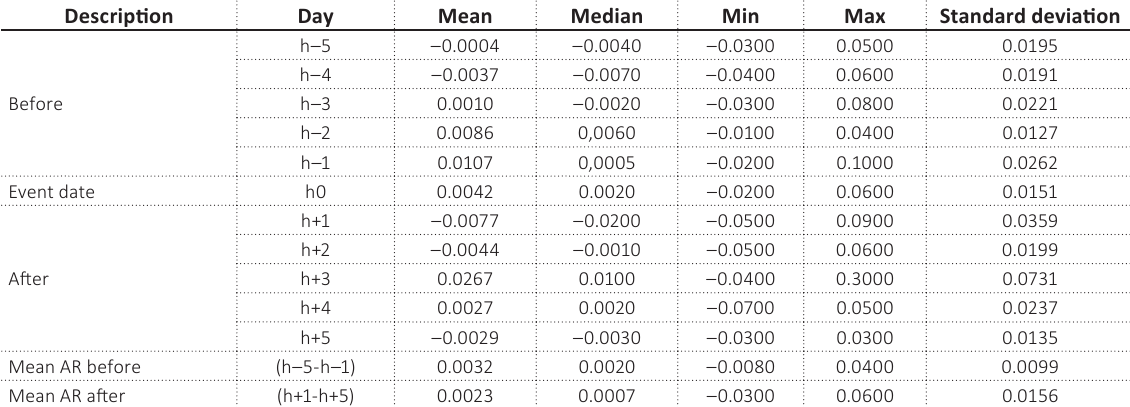
Table 3. Statistical description of abnormal returns data